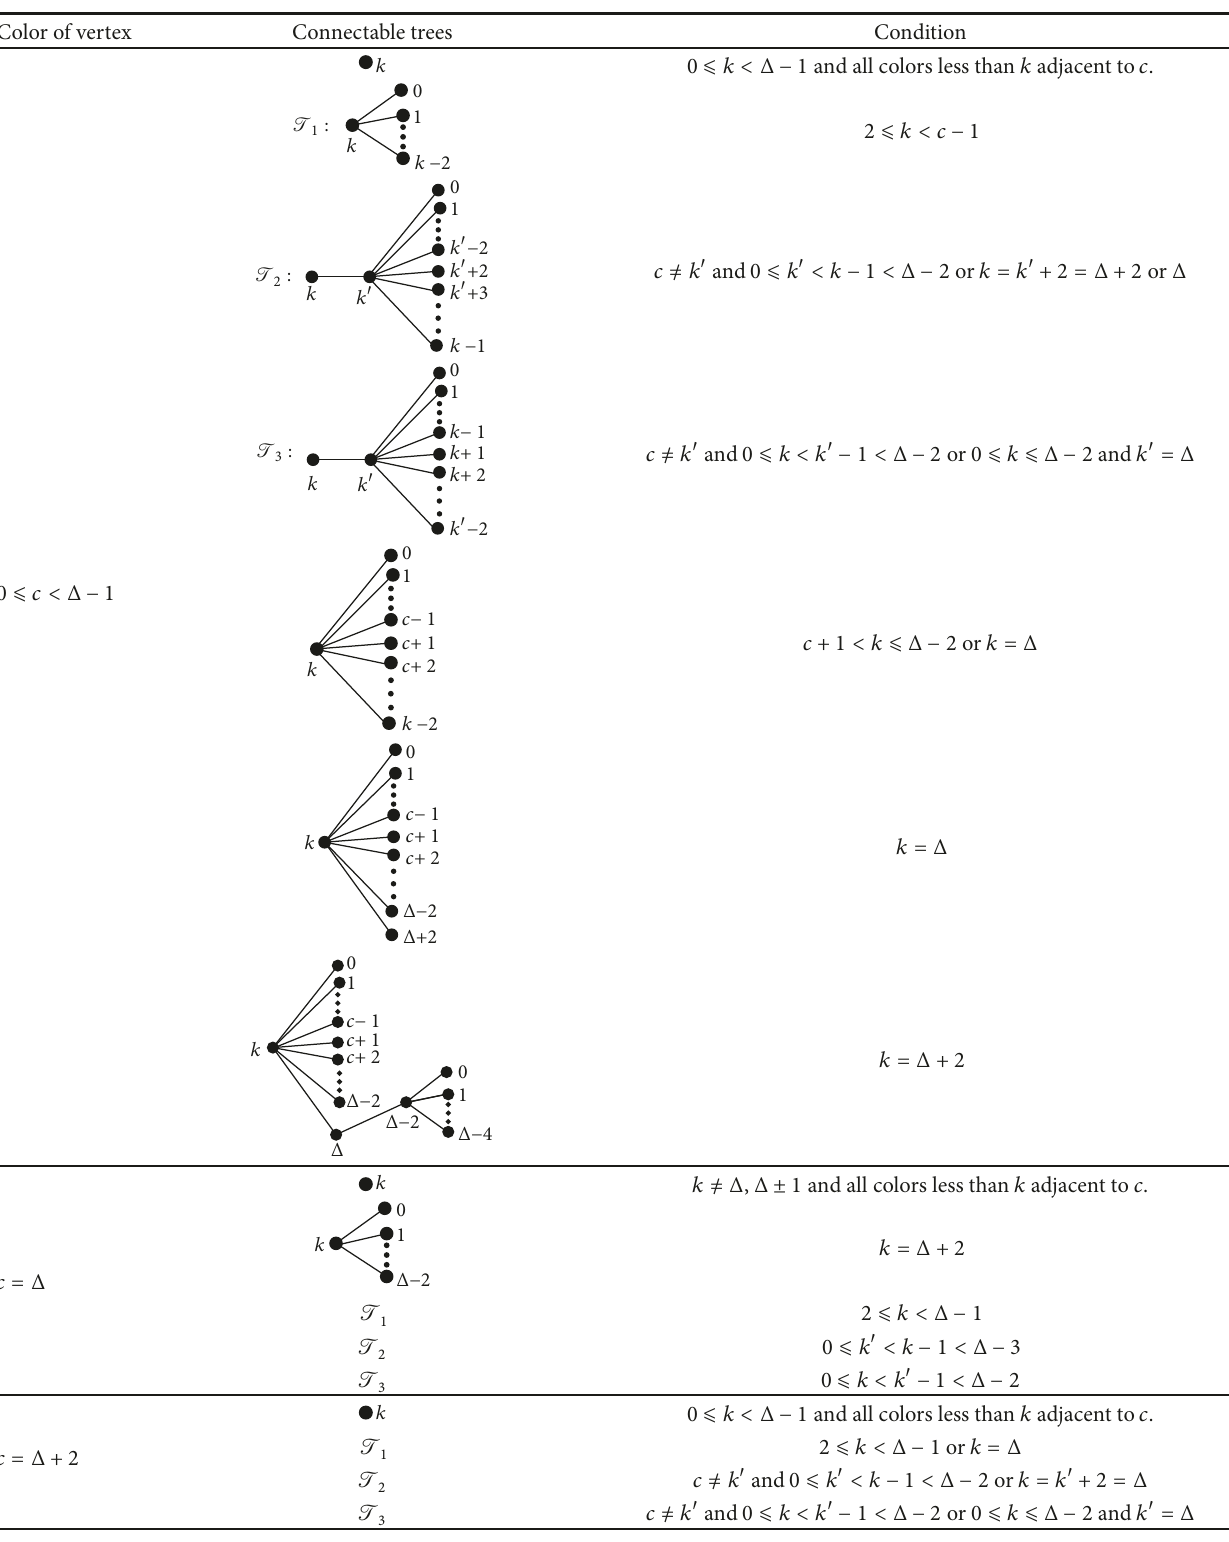
Table 3: Trees connectable to a vertex 𝑢 colored 𝑐 in a two-hole tree with Δ − 1 and Δ + 1 as holes. Color of vertex Connectable